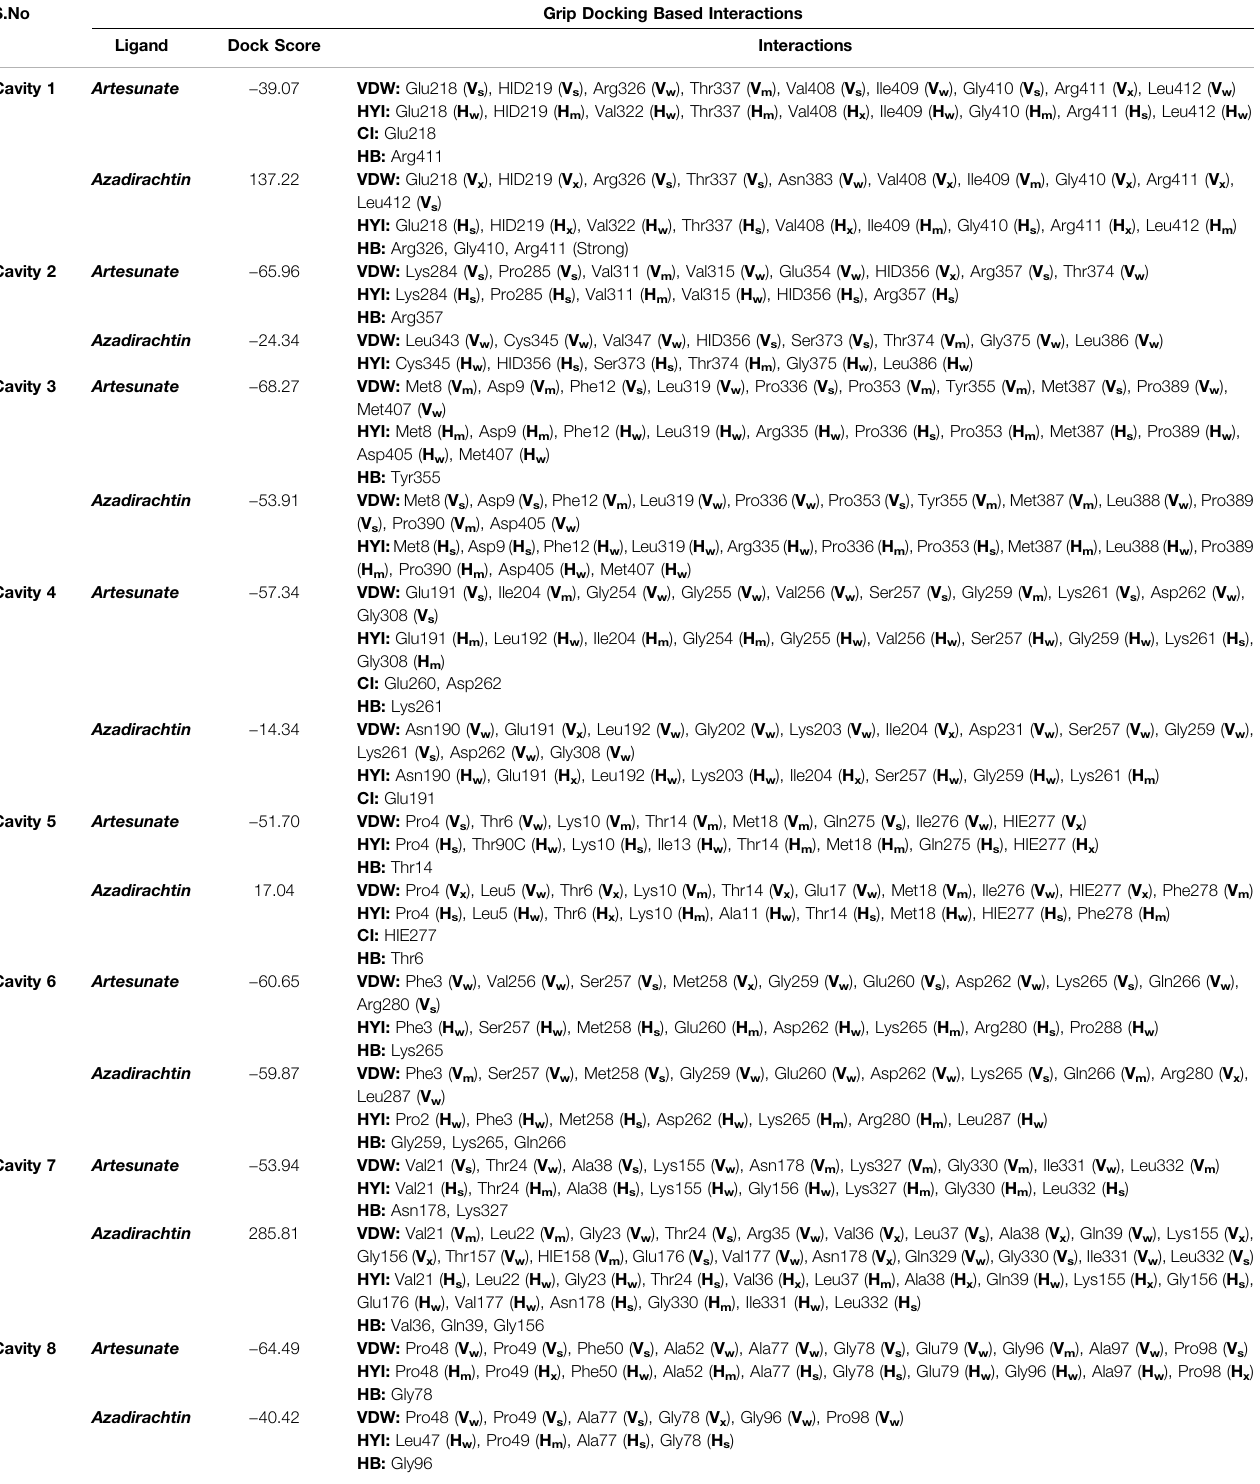
TABLE 2 | Grip docking-based interactions study of artesunate and azadirachtin with all the cavities of cleaned and optimized Gephyrin E domain (6FGC), apo_snapshot1. HID: Histidine with hydrogen on the delta nitrogen; HIE: Histidine with hydrogen on the epsilon nitrogen. S.No Grip Docking Based